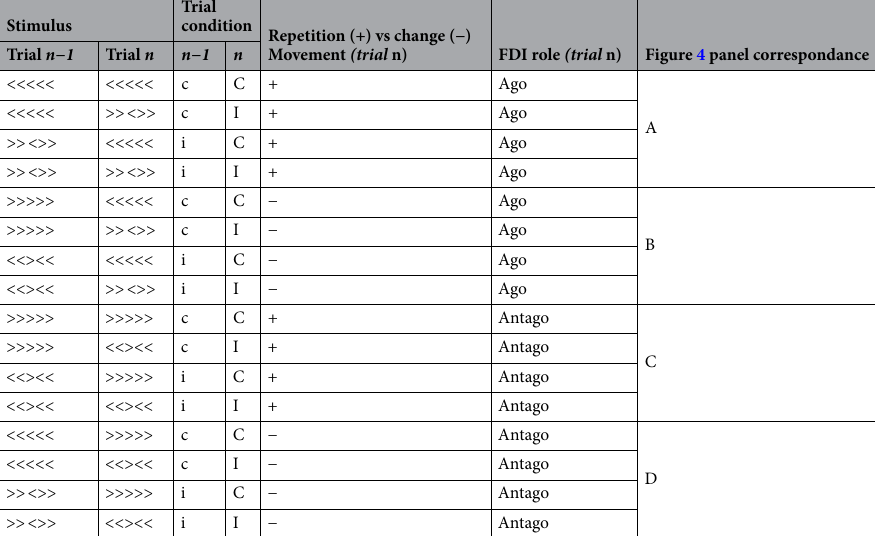
(Fig. 1B and Table 1) were used in the task: in the congruent condition, four flanker arrows appeared beside the central arrow, pointing in the same direction (<<<<< or >>>>>). In the incongruent condition, the flanker arrows pointed in the opposite direction (flexion for >> <>> and extension for <<><<). In both congruent and incongruent conditions, subjects were instructed to respond by flexing or extending their index according to the central arrow direction. All stimuli were presented in white on a black background. Task stimuli were manipu- lated and presented in a pseudo-random order in order to satisfy the following parameters: (1) congruent (C) and incongruent (I) trials were presented in equivalent proportions; (2) similar number of trials for movement direction demanded for responding to the central arrow (left pointing arrow = first dorsal interosseous (FDI) muscle contraction (FDI agonist) or right pointing arrow = extensor indicis (EI) muscle contraction (FDI antag- onist movement)); (3) similar number of trials regarding the movement history (repetition, i.e. two successive